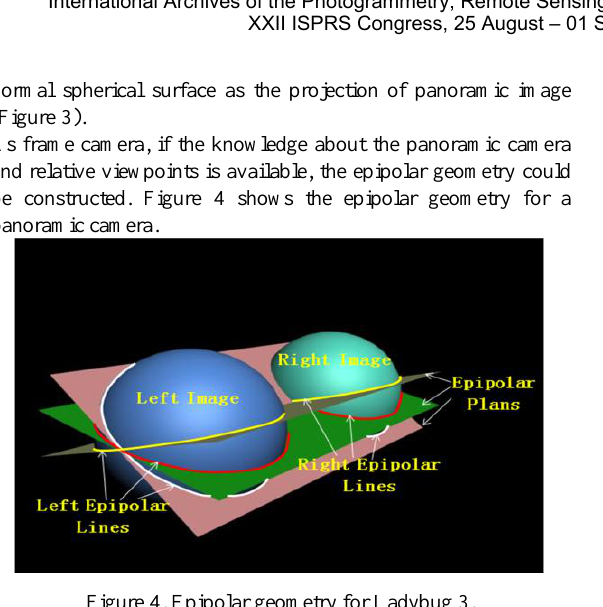
Figure 7. Resampled panoramic epipolar image for stereo viewing and its zigzag epipolar lines.